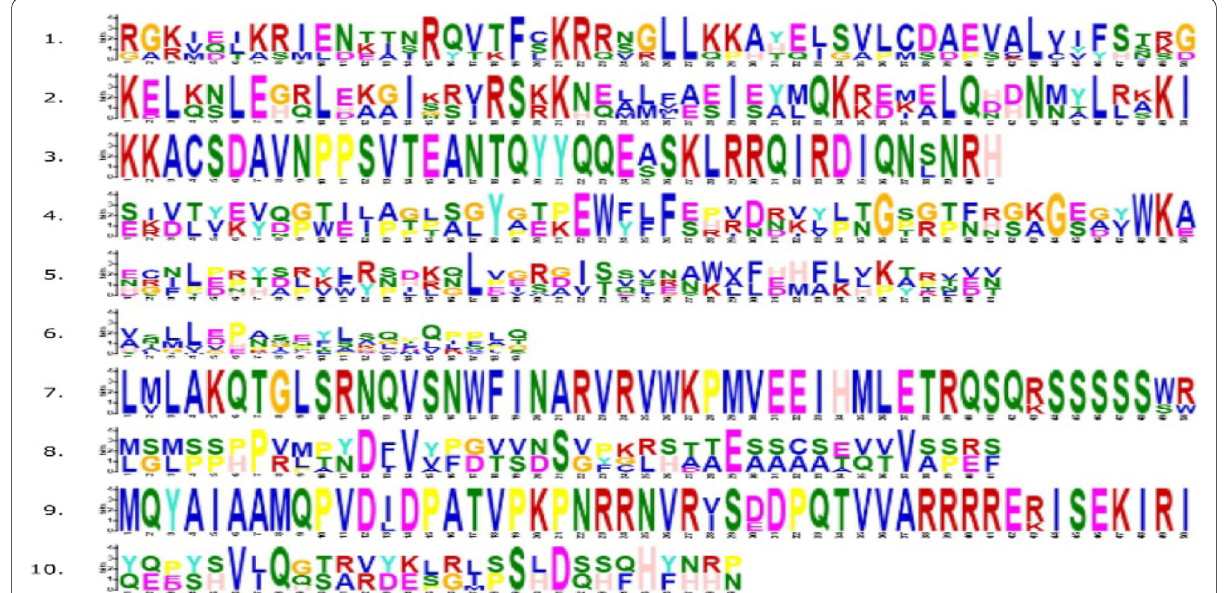
Fig. 3 Logos of tens motifs discovered in shattering